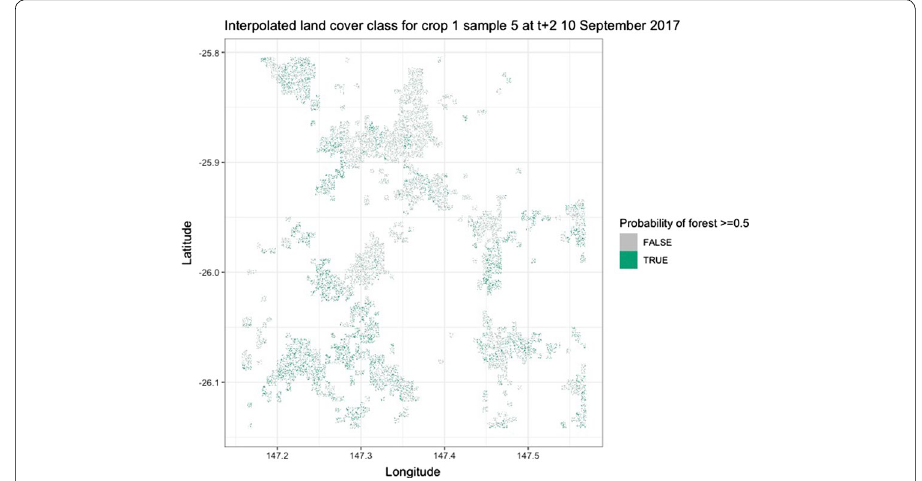
Fig. 8 Interpolated land cover class as a binary land cover classification; forest and not forest, plotted by spatial coordinates. Green indicates forest and grey indicates not forest